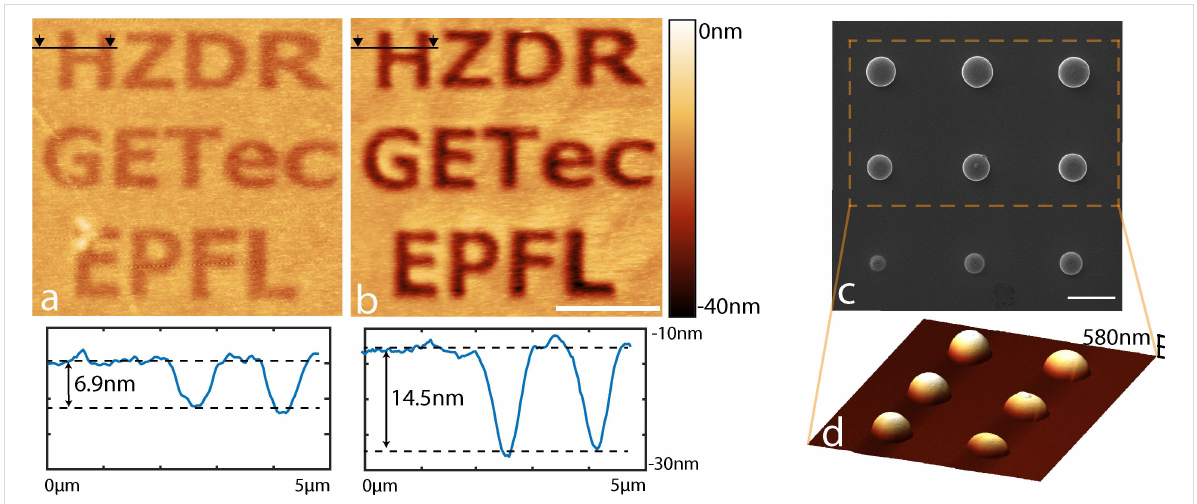
Figure 3: AFM height images of poly(methyl methacrylate) after exposure to a) 1 × 10 13 and b) 3 × 10 13 He ion cm − 2 . The images were taken in con- tact mode, scale bar 4 µm. c) Silicon bubbles imaged with HIM (scale bar 1 µm) and d) AFM (off-resonance tapping mode).